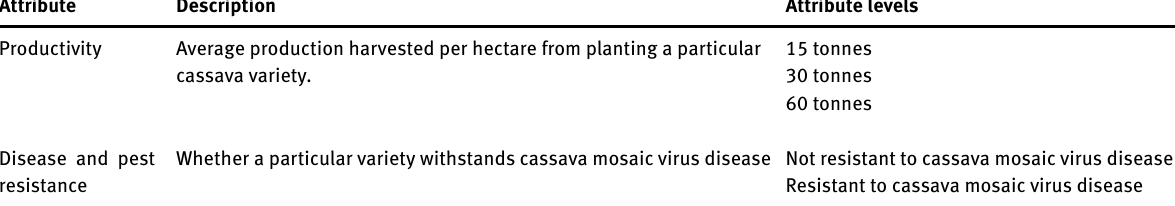
Table 1: Attributes and attribute levels used in the choice experiment Attribute Description Productivity